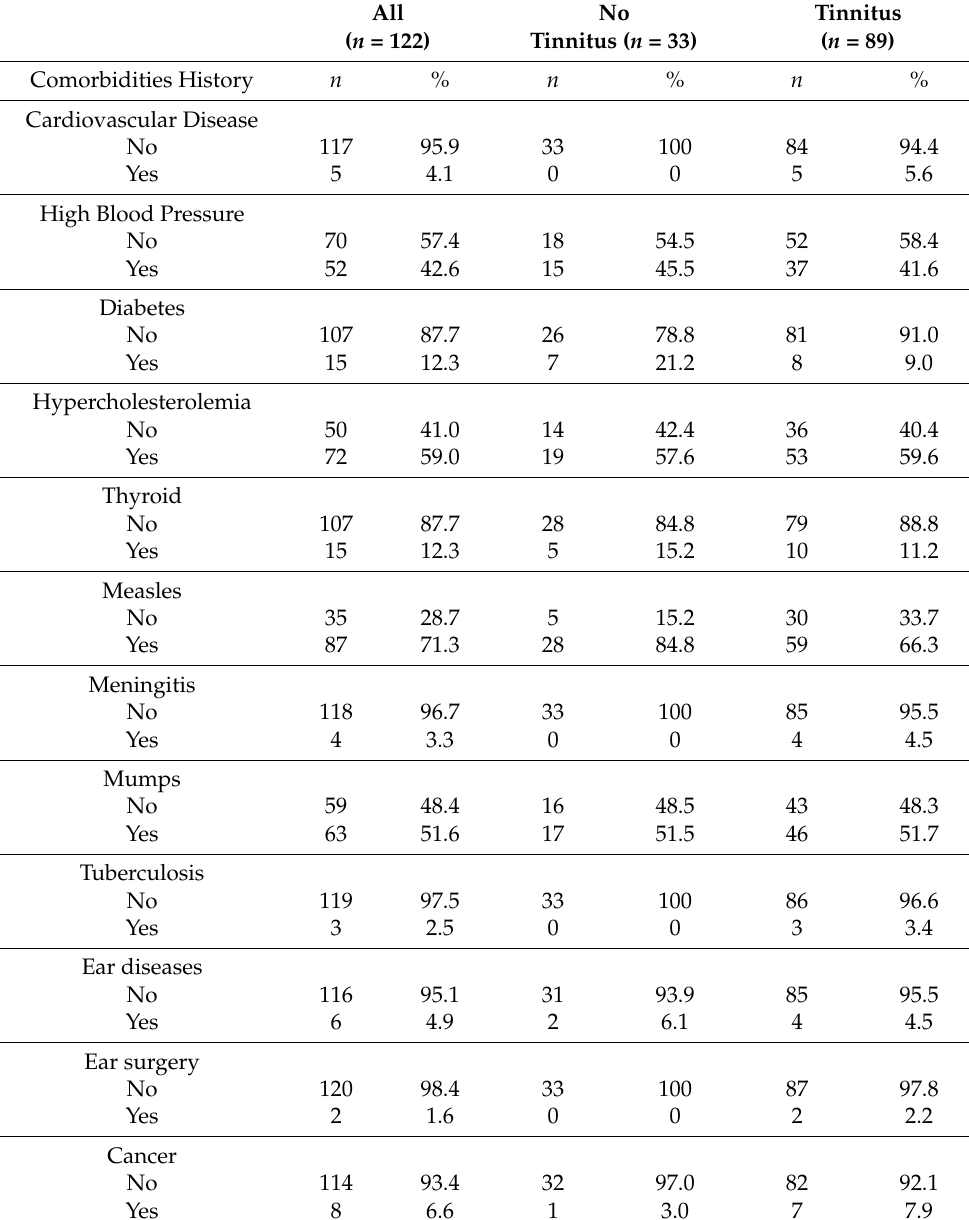
Table 4. History of comorbidities.